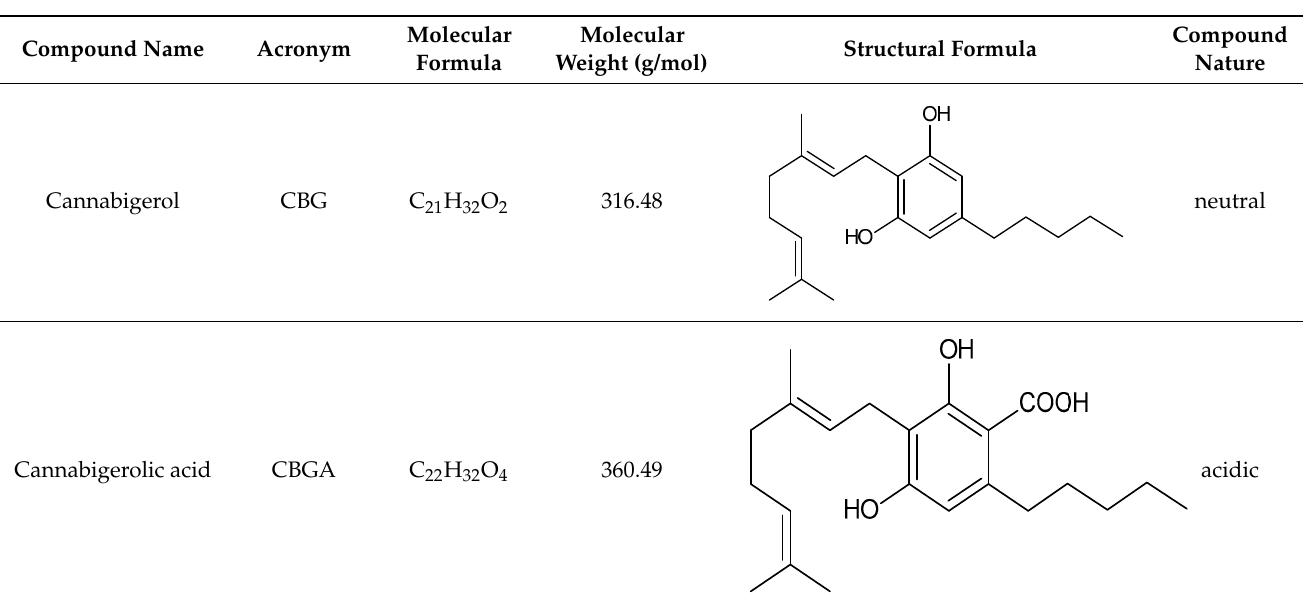
Table 1. Chosen cannabinoids isolated from Cannabis sativa L. [1,14,30,33–35].